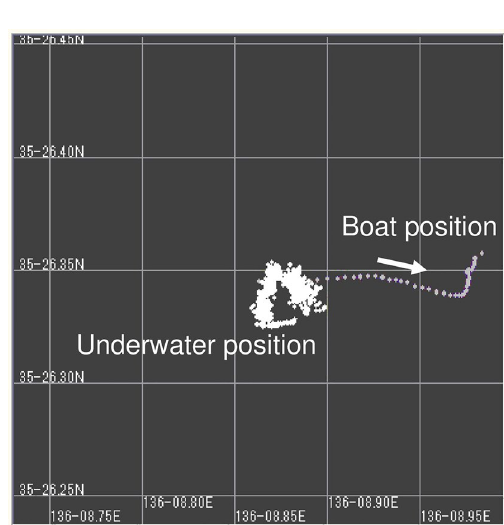
Fig. 18 Underwater position of the robot at 58 m